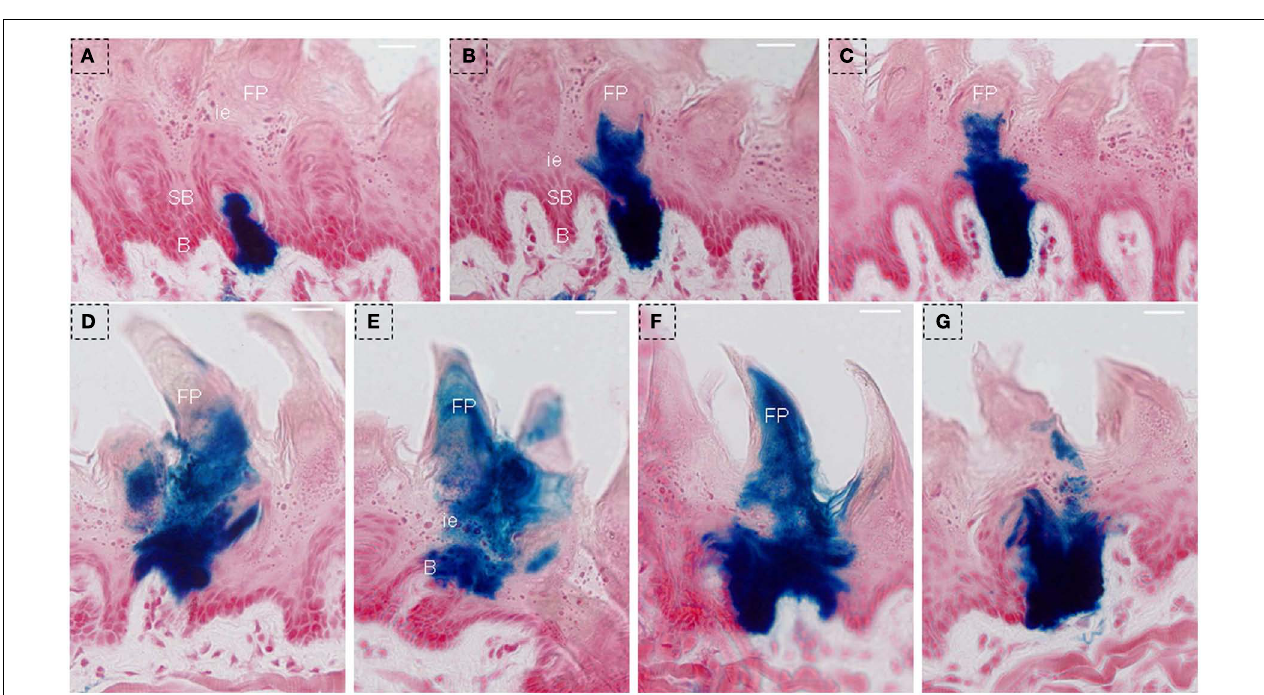
cluster diameter is ∼ 60–70 µ m (A–C) . Serial frontal sections showed LacZ staining across the lingual epithelia, extending into the whole filiform papillae. The diameter of this cluster is ∼ 80–90 µ m (D–G) . B, basal cell layer; SB, suprabasal cell layer; CT, connective tissue; FP, filiform papillae; FuP, fungiform papillae; ie, interpapillary epithelia;TB, taste bud. Scale bar: 12 µ